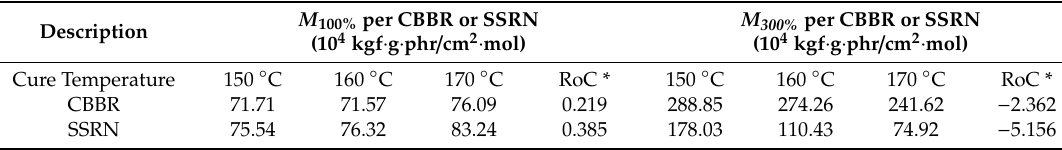
Table 6. Mechanical properties per one phr of filler by different cure temperatures.